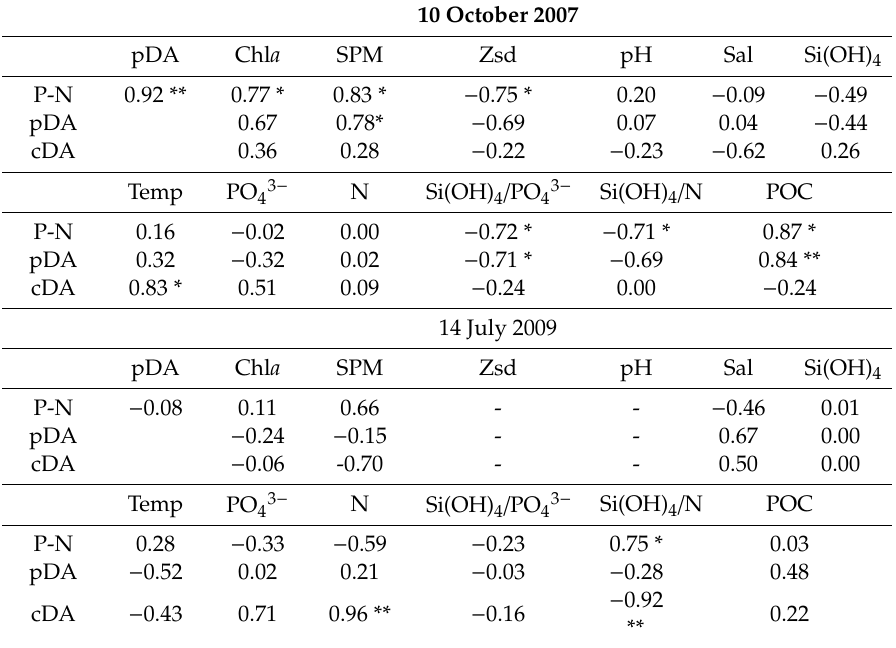
Table 3. Pearson’s correlations between Pseudo-nitzschia spp. abundances (P-N in cells L − 1 ),